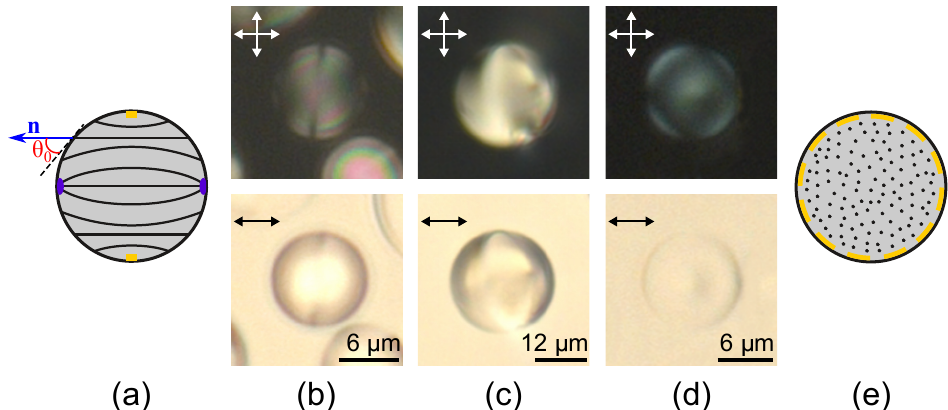
Figure 1. The nematic LN-396 droplets with the axial-bipolar configuration. Scheme of the director field in the droplet central section passing through the bipolar axis ( a ). POM (polarising optical microscopy) photos of the droplets with the bipolar axis oriented parallel ( b ), at approximately 60 ◦ angle ( c ) and perpendicular ( d ) to the sample plane taken in the crossed polarisers (top row) and without analyser (bottom row). Scheme of the director field in the central section perpendicular to the bipolar axis ( e ). Violet semicircles indicate the surface point defects, the orange rectangles indicate the sections of circular defect in ( a ), and the orange dashed line indicates the circular defect in ( e ). Hereinafter, the orientation of polarisers is indicated by the double